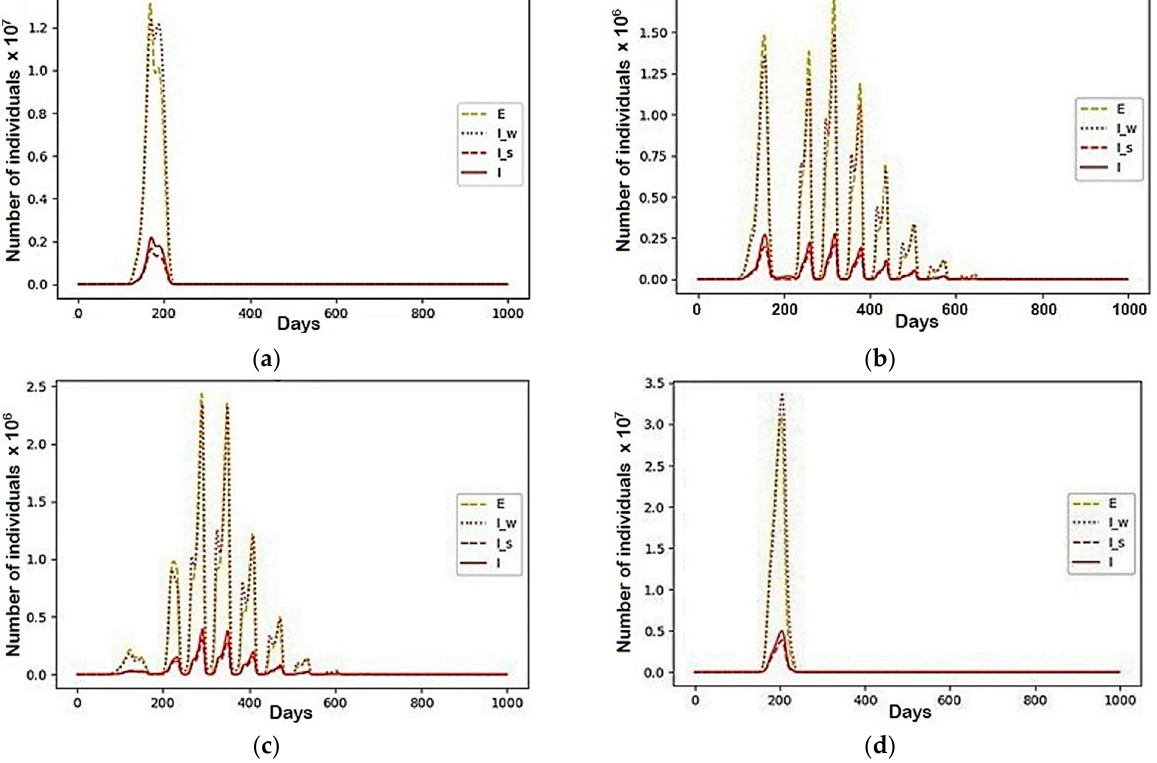
Figure 8. A scenario in which a 1 = 1, b 1 = − 0.1, b 4 = 0.05, c 1 = − 0.15, c 4 = 0.1, d 1 = − 0.3, d 2 = − 0.7 , and the rest are equal to zero: ( a ) Region 1; ( b ) Region 2; ( c ) Region 3; ( d ) Region